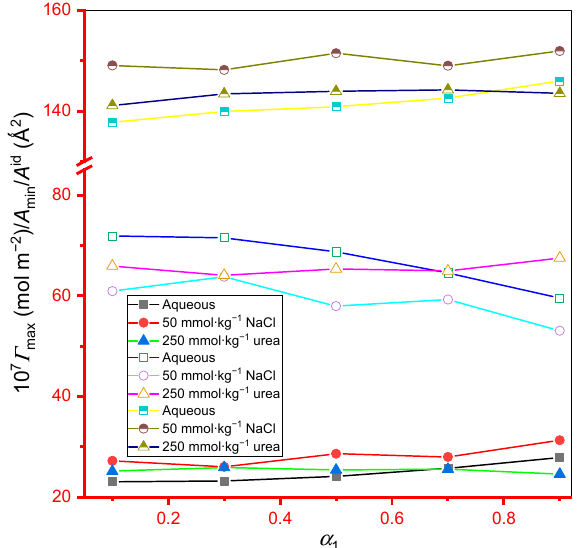
Figure 1. Plot of Γ max / A min / A id against α 1 plot for IMP+TX-100 mixture in different media (filled, open, and half-filled symbols represent Γ max , A min , and A id , respectively).